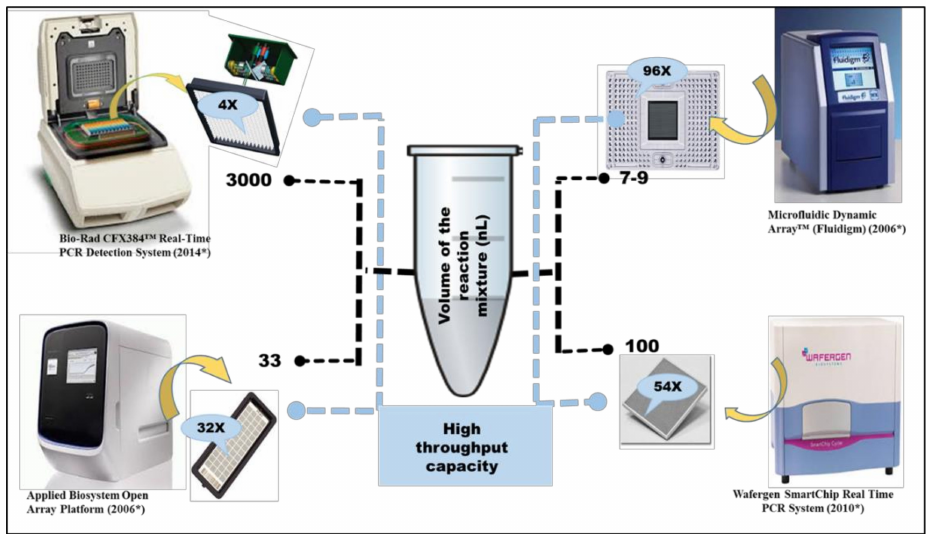
Figure 3. Reaction Volume and High throughput capacity of various HT-qPCR platforms used for ARGs